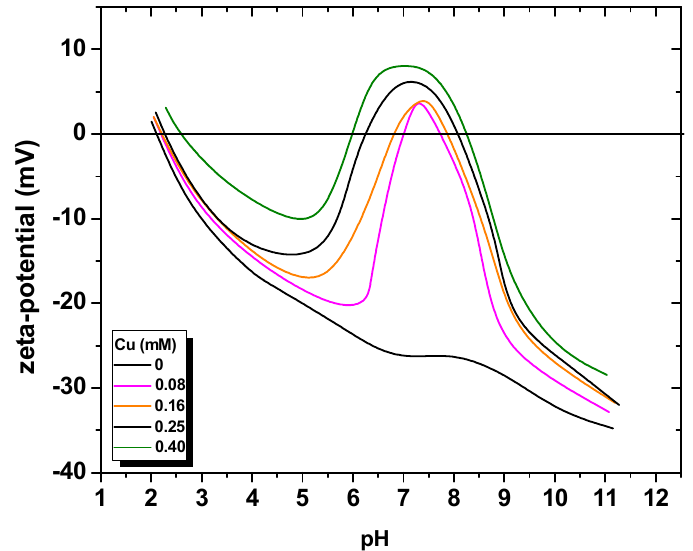
Figure 2. Zeta-potential measurements of pyrite in the presence of copper ions. Redrawn from Taylor and Francis [38] .